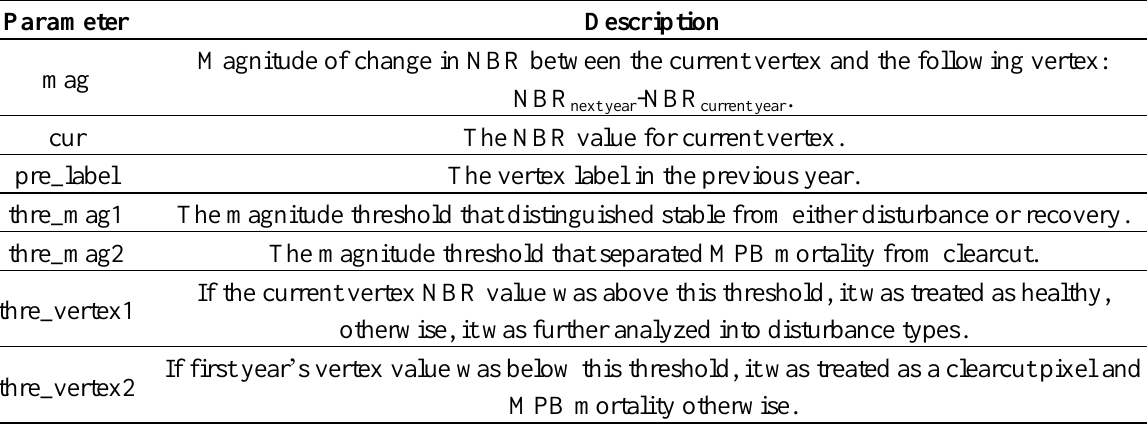
Table 4. Abbreviations and control parameters used in the decision